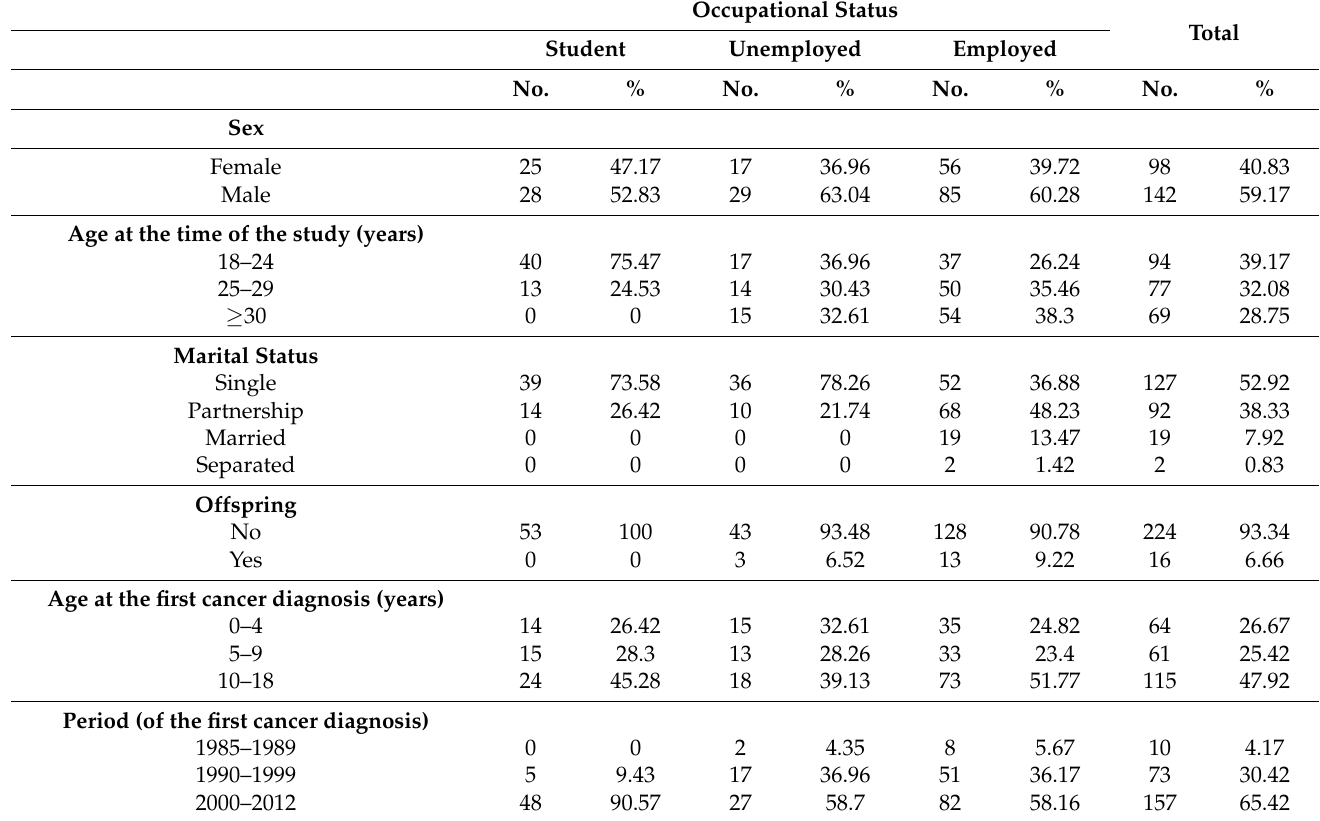
Table 1. Socio-demographic and clinical characteristics according to occupational status.